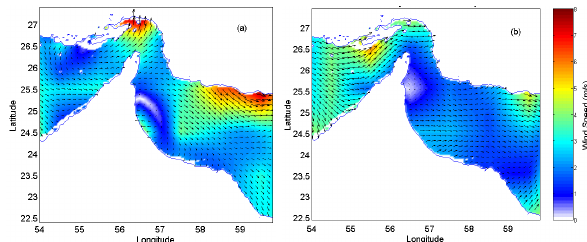
Fig. 3. Typical mean monthly wind fields on the model domain in (a) February and (b) and May